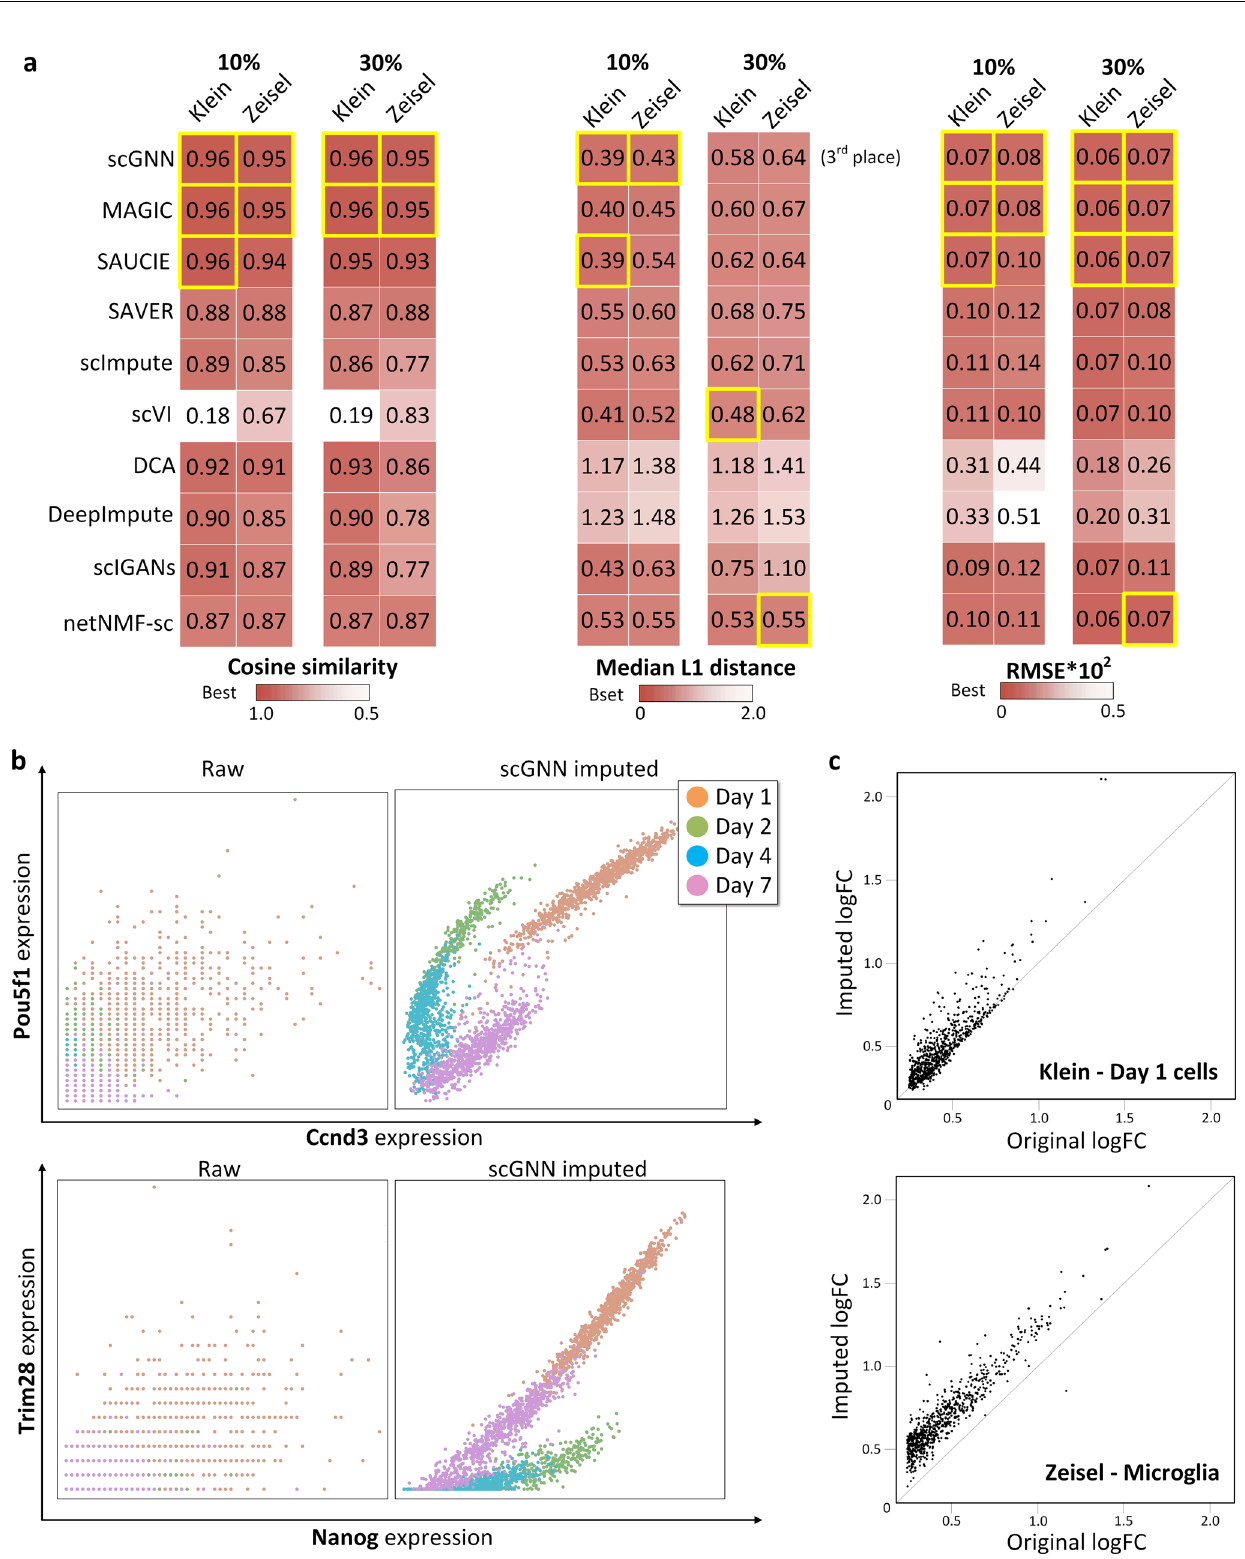
Fig. 3 Comparison of the imputation performance. a Comparison of the cosine similarity, median L1 distance, and RMSE scores between scGNN and other nine imputation tools under 10 and 30% synthetic dropout rate. Darker color indicates better performances. The highest score in each column is highlighted with the yellow box. RMSE scores were scaled by multiplying by 100. b Co-expression patterns can be addressed more explicitly after applying scGNN on the Klein data. No clear gene pair relationship of Ccnd3 versus Pou5f1 (upper panel) and Nanog versus Trim28 (lower panel) is observed in the raw data (left) compared to the observation of unambiguous correlations within each cell type after scGNN imputation (right). c Comparison of DEG logFC scores using the original expression value ( x axis) and the scGNN imputed expression values ( y axis) identi fi ed in day 1 cells of the Klein data (up) and microglial cells of the Zeisel data (bottom). The differentiation signals are ampli fi ed after imputation.